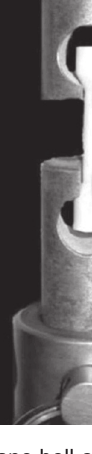
Figure 1- Polyurethane bell-shaped specimen positioned for tension tests